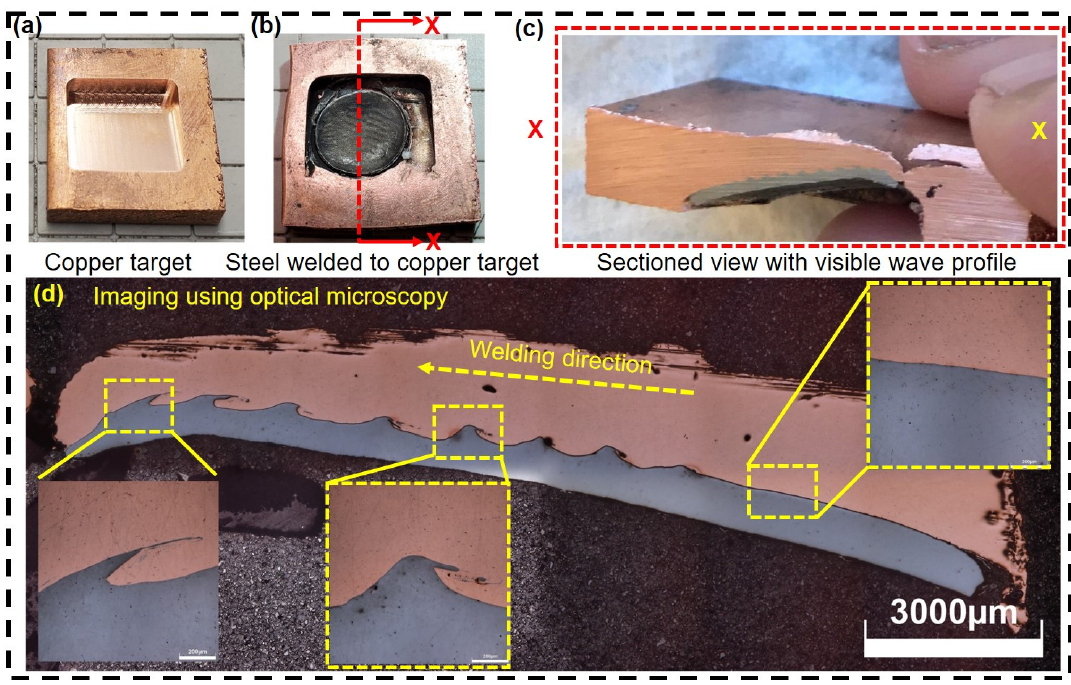
Figure 7. ( a ) Copper target grooved with 20° inclination, ( b ) steel welded to copper target, ( c ) sectional view of the welded part, and ( d ) optical image showing complete welding profile.